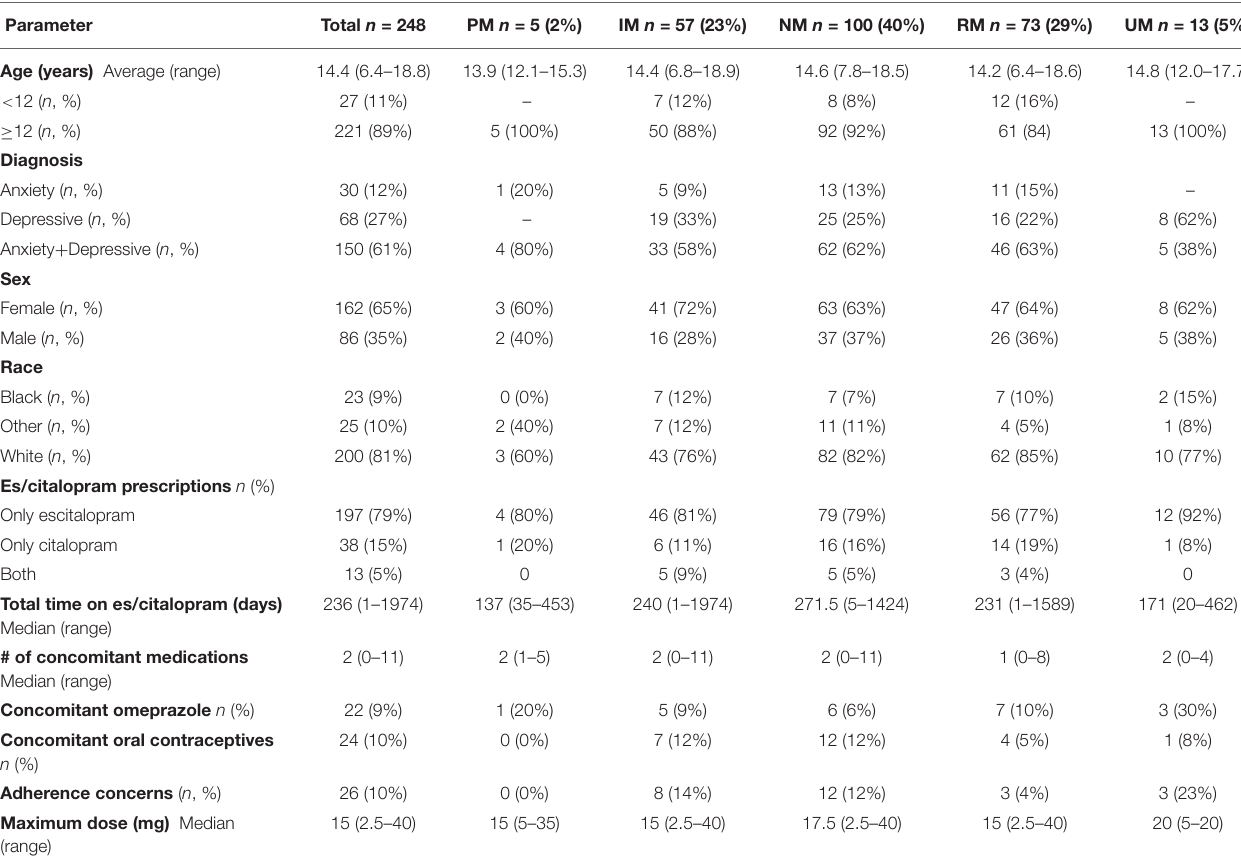
TABLE 1 | Demographic and prescription data of tolerability cohort by CYP2C19 phenotype.